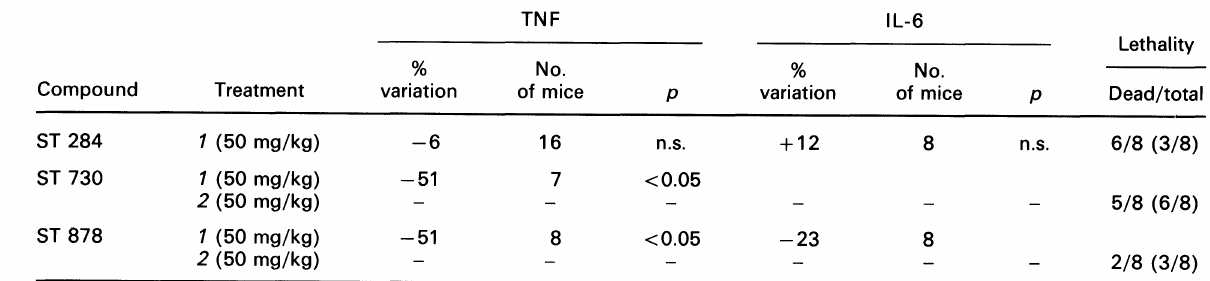
Table 5. Effects of isobutyryI-L-carnitine (ST 284) and its derivatives (ST 730, ST 878) on both serum TNF and IL-6 production, and lethality of mice challenged with